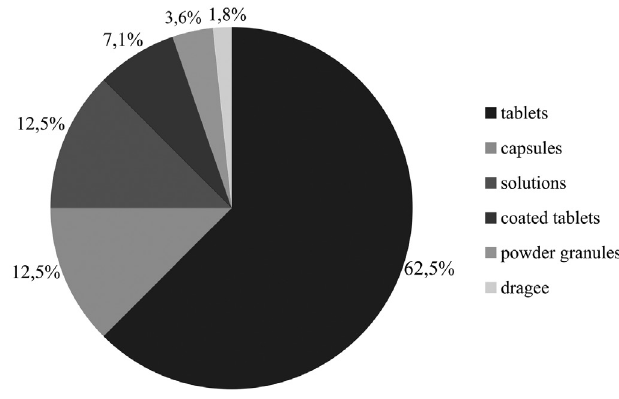
FIGURE 1 - Percentage of pharmaceutical forms of medicines prescribed by enteral feeding tubes between January and June, 2007 among the 26 patients analyzed at the Hospital dos Servidores do Estado in Rio de